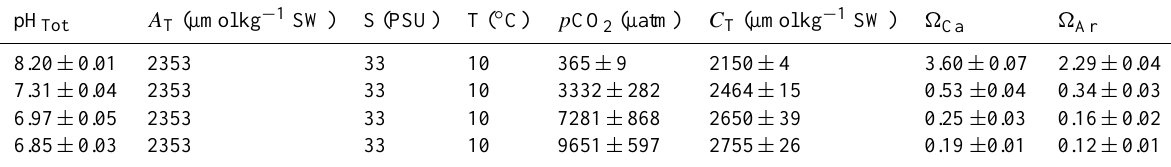
Table 1. Carbonate system speciation in the experimental treatments. Total dissolved inorganic carbon ( C T ) , p CO 2 and calcium carbonate saturation state for calcite and aragonite ( (cid:127) Ca , (cid:127) Ar ) were calculated from pH and total alkalinity ( A T ) . Listed values represent means ±